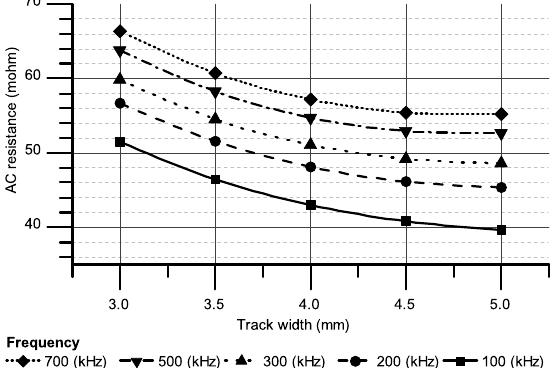
Figure 7. AC resistances of three-turn PCB